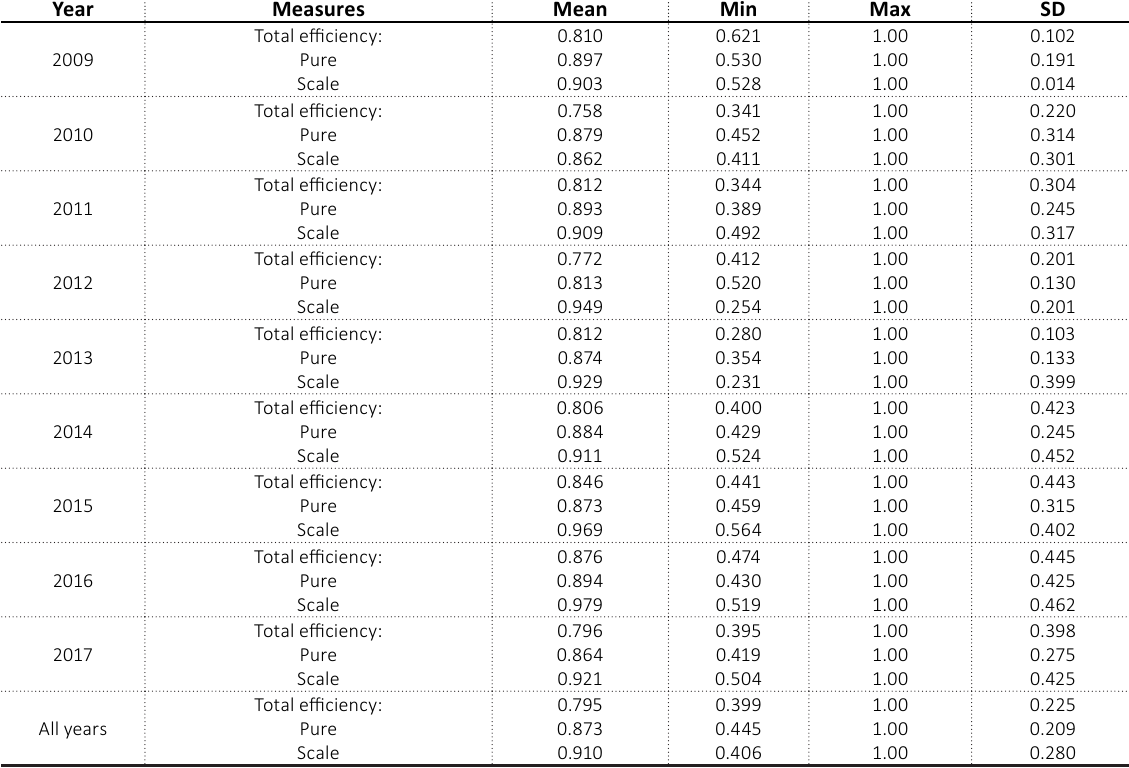
Table 10. Measures of efficiency of conventional banks with Islamic windows after the